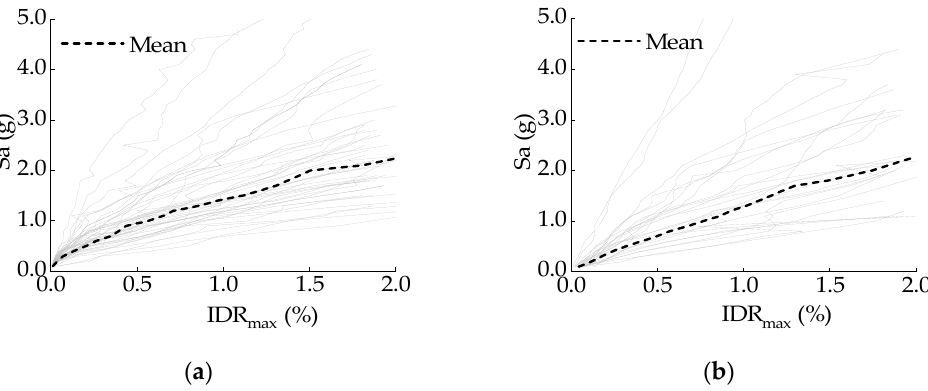
Figure 8. The IDA curves of the two structures: ( a ) 4-story; ( b ) 8-story.